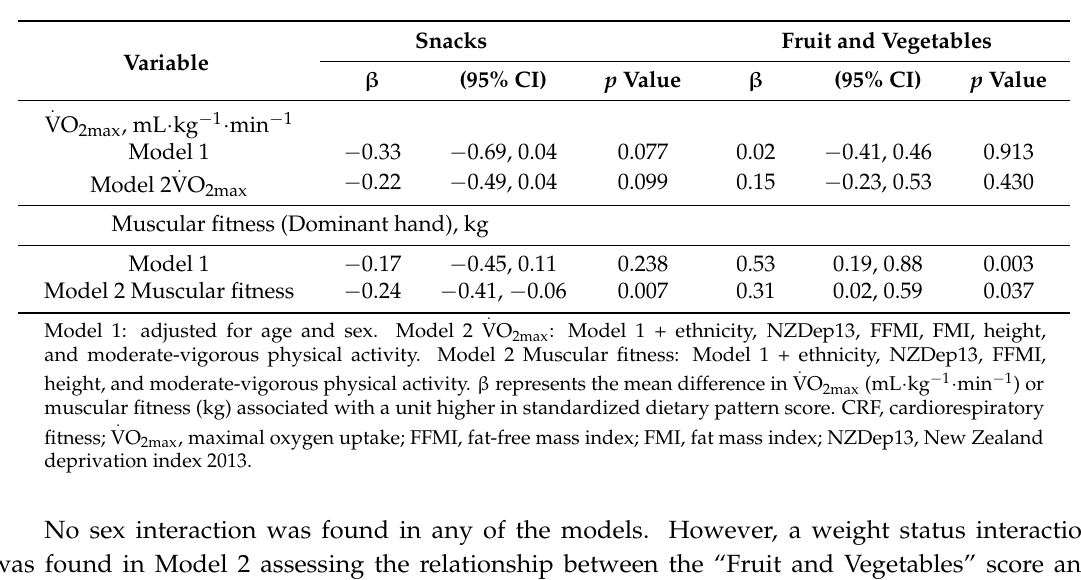
Table 2. Relationships between dietary pattern scores and CRF and muscular fitness. Snacks Fruit and Vegetables Variable β